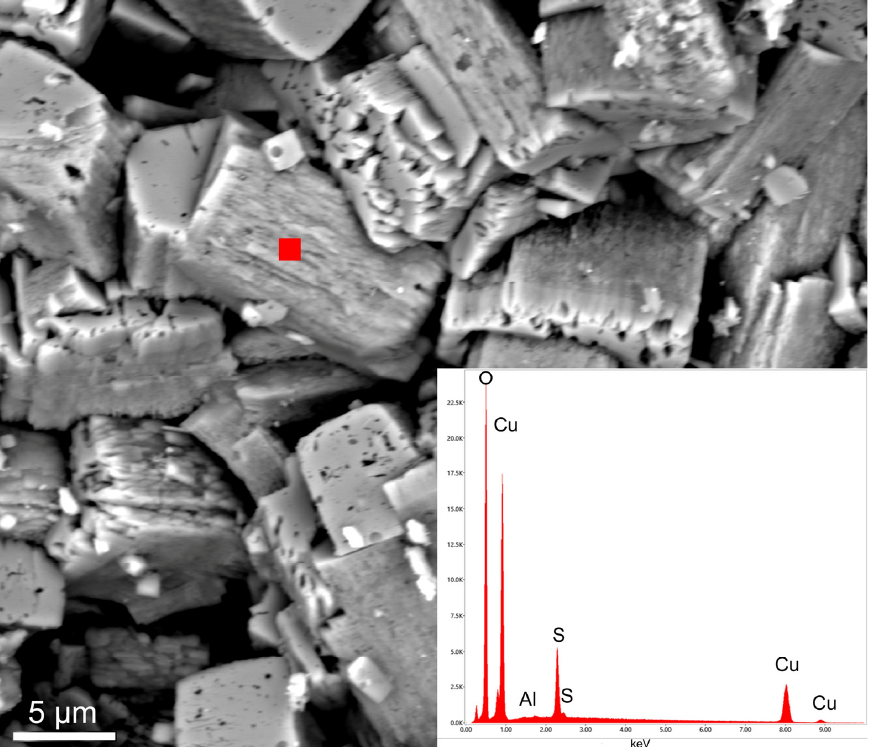
Appl. Sci. 2023 , 13 , x FOR PEER REVIEW Figure 18. SEM image and corresponding EDS spot analysis (red filled square) of spongy-looking posnjakite crystals from the Mastricarro Barite Mine (Catanzaro, southern Italy).